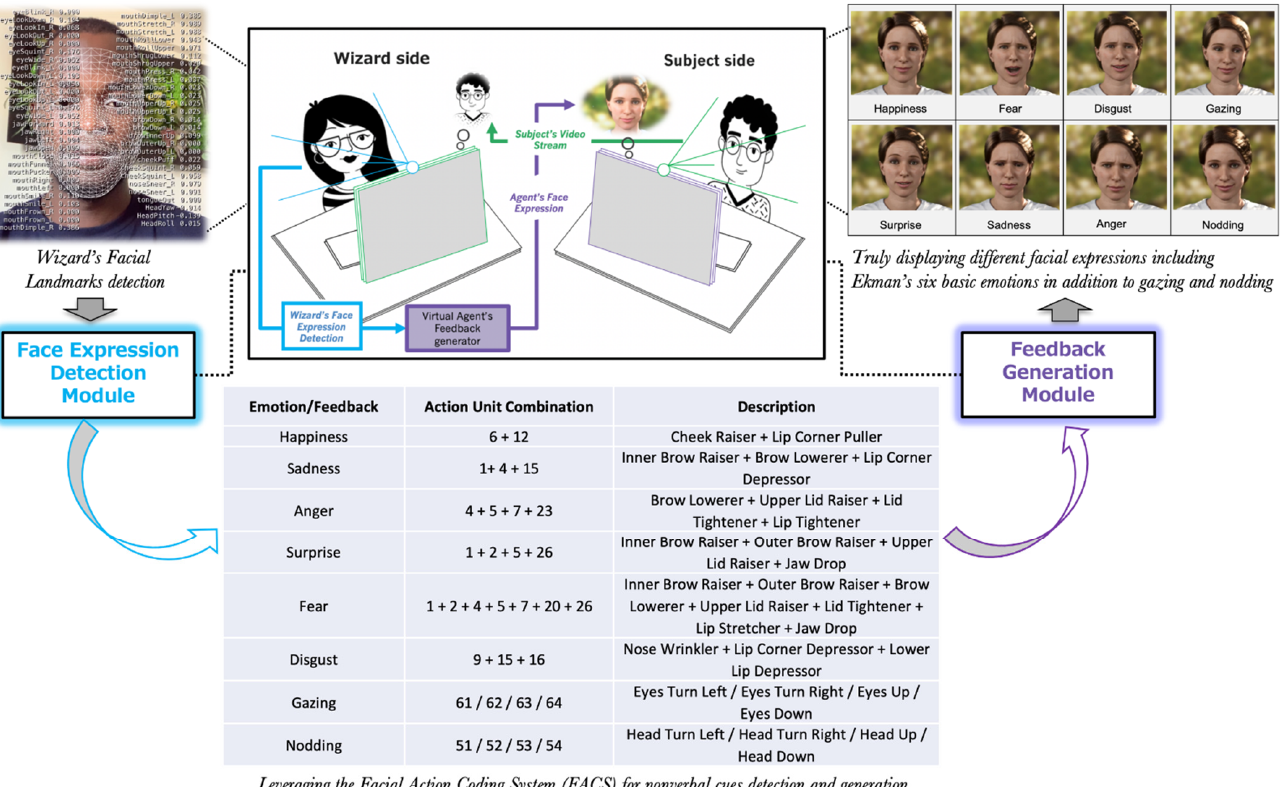
Figure 2. Overview of the proposed WoZ experimental environment. The wizard’s facial expres- sions are detected via the face expression detection module (left-hand side). Based on the detected expression, the virtual agent’s facial expression is generated via the feedback generation module (right-hand side) by combining several action units as specified in the FACS (center).